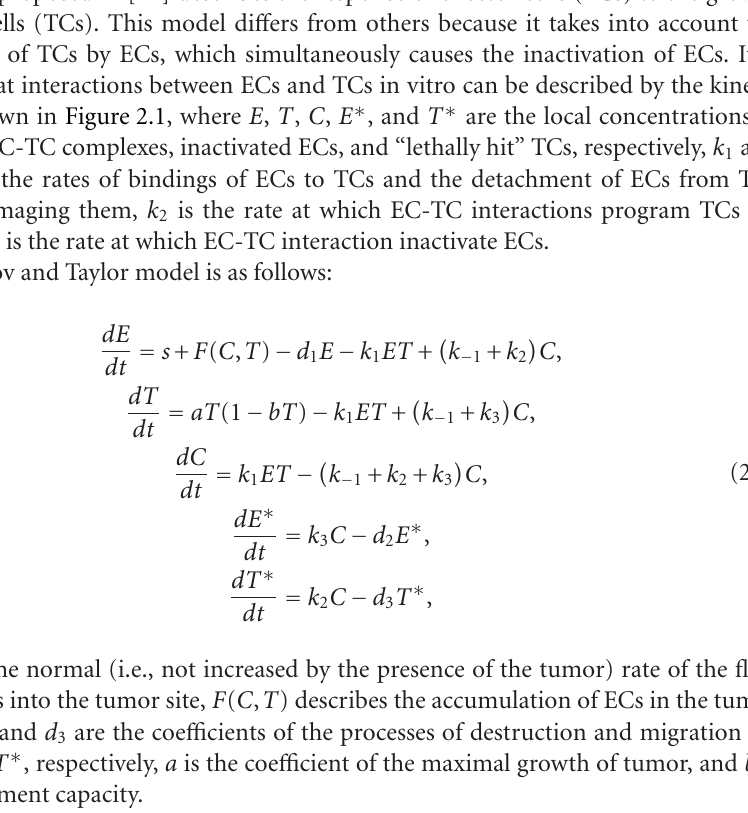
Figure 2.1. Kinetic scheme describing interactions between ECs and TCs (see